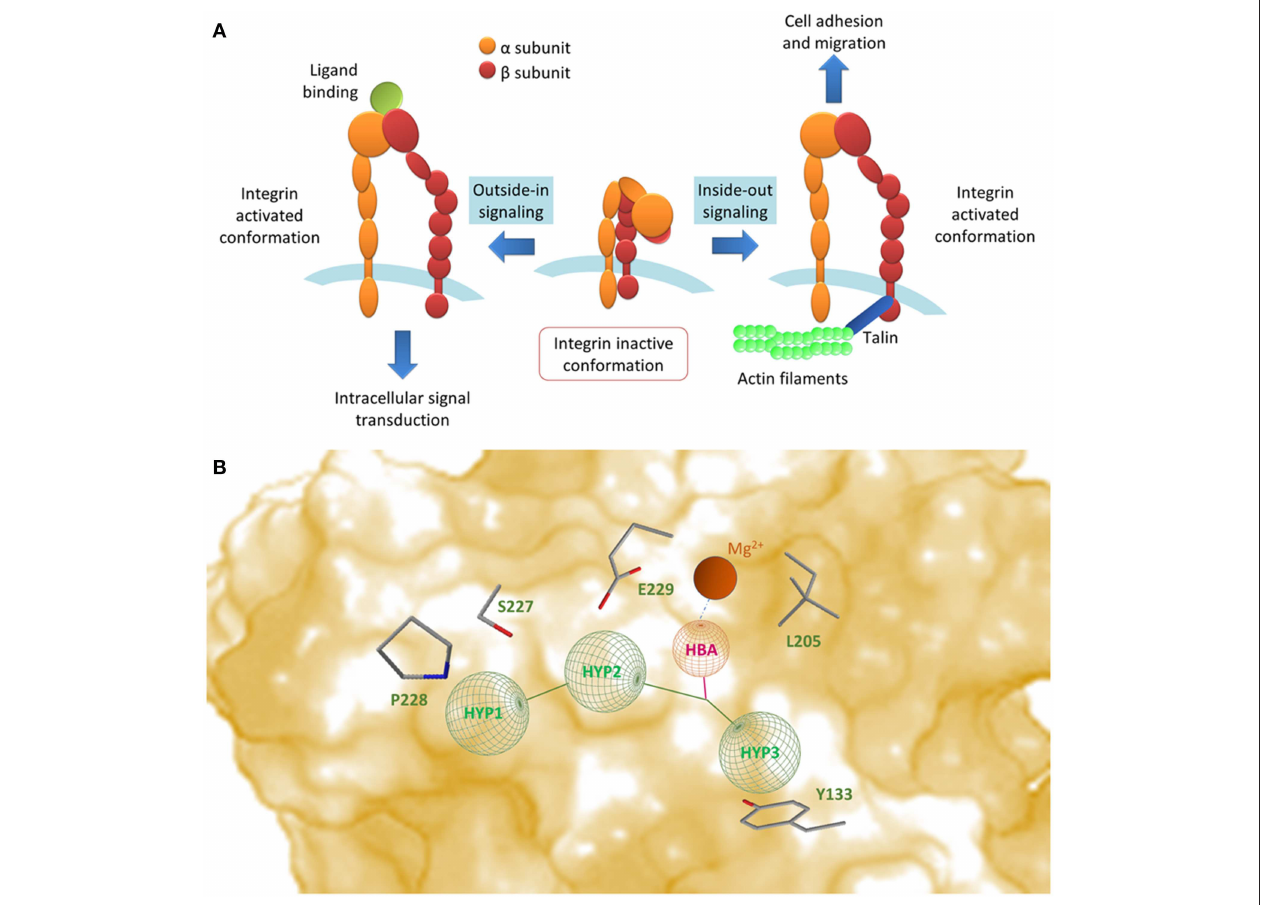
FIGURE 1 | (A) Integrins propagate signals bidirectionally across cell membrane: conformational changes in their extracellular domains can occur as a consequence of signaling events happening inside the cells (inside-out signaling); these events lead to an increase in affinity (integrin activation) and therefore lead to ligand binding and cell adhesion. On the contrary, outside-in signaling represents the process in which ligand binding and ligand-induced integrin clustering lead to integrin-mediated intracellular signal transduction (Abram and Lowell, 2009; Ley et al., 2016). (B) Schematic representation of small molecule ligand binding mode to α 4 β 1 integrin, obtained by combining the models reported in the literature. Side chains of selected residues in the β 1 unit have been indicated. HBA, hydrogen bond acceptor; HYP1, valine mimetic hydrophobic pocket; HYP2-3, leucine mimetic hydrophobic pockets.